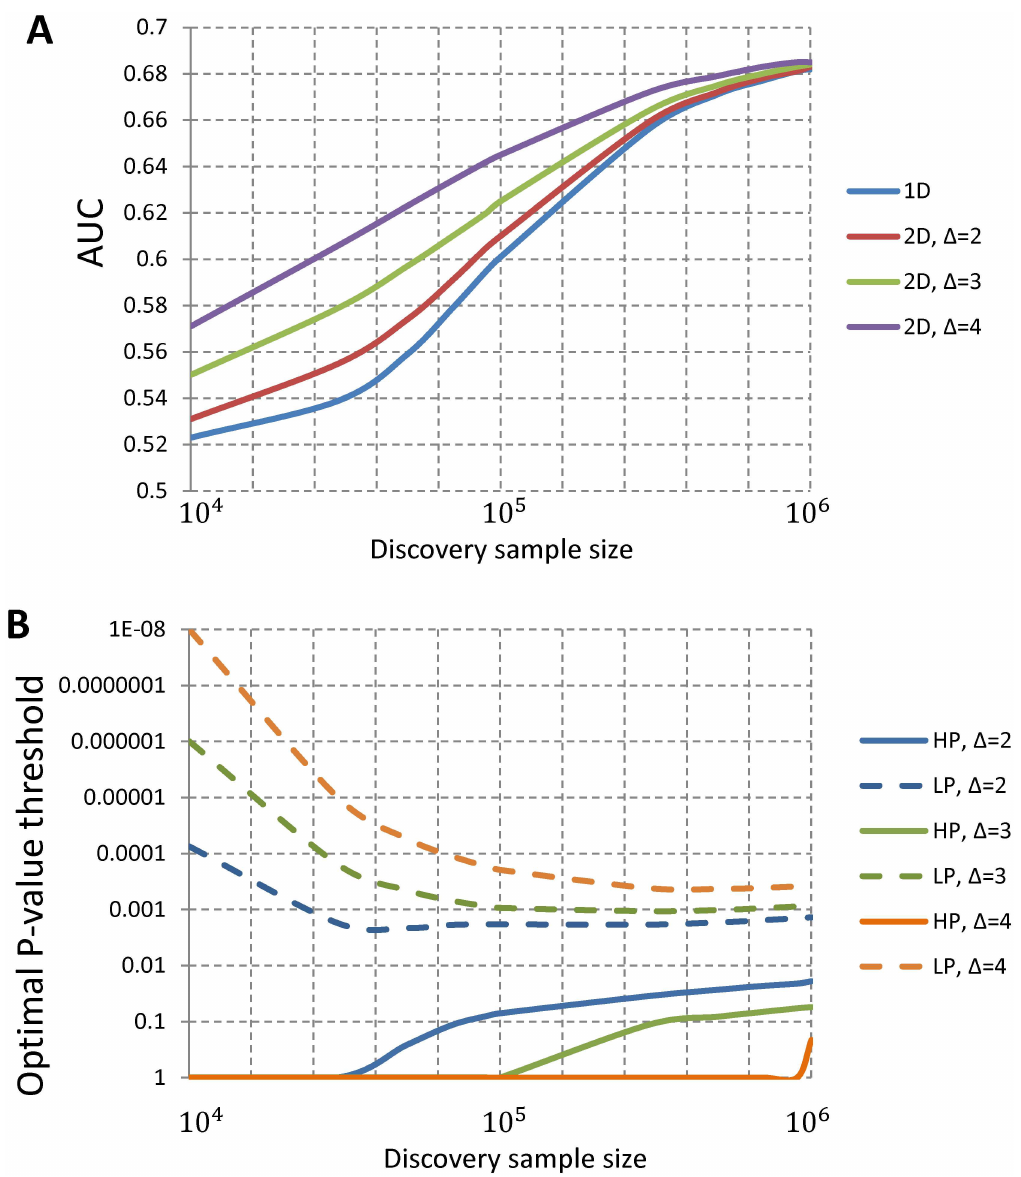
Fig 1. Theoretic investigation of prediction performance and optimal thresholds for SNP selection in 2D PRS. The theoretic calculationassumes M = 53,163 independentSNP, of which 5,000 are causal for a binary trait, similar to simulationstudies. The high-prior(HP) SNP set has 5,000 SNPs and the low-prior(LP) SNP set has 48,163 SNPs. Δ is the enrichment fold of HP SNPs in the causal SNP set. (A) The predictionAUC for 1D PRS and 2D PRS. (B) The optimalP-value thresholds for includingHP and LP SNPs in 2D PRS. For both plots, x-coordinateis the discovery sample size, assumingequal numberof cases and